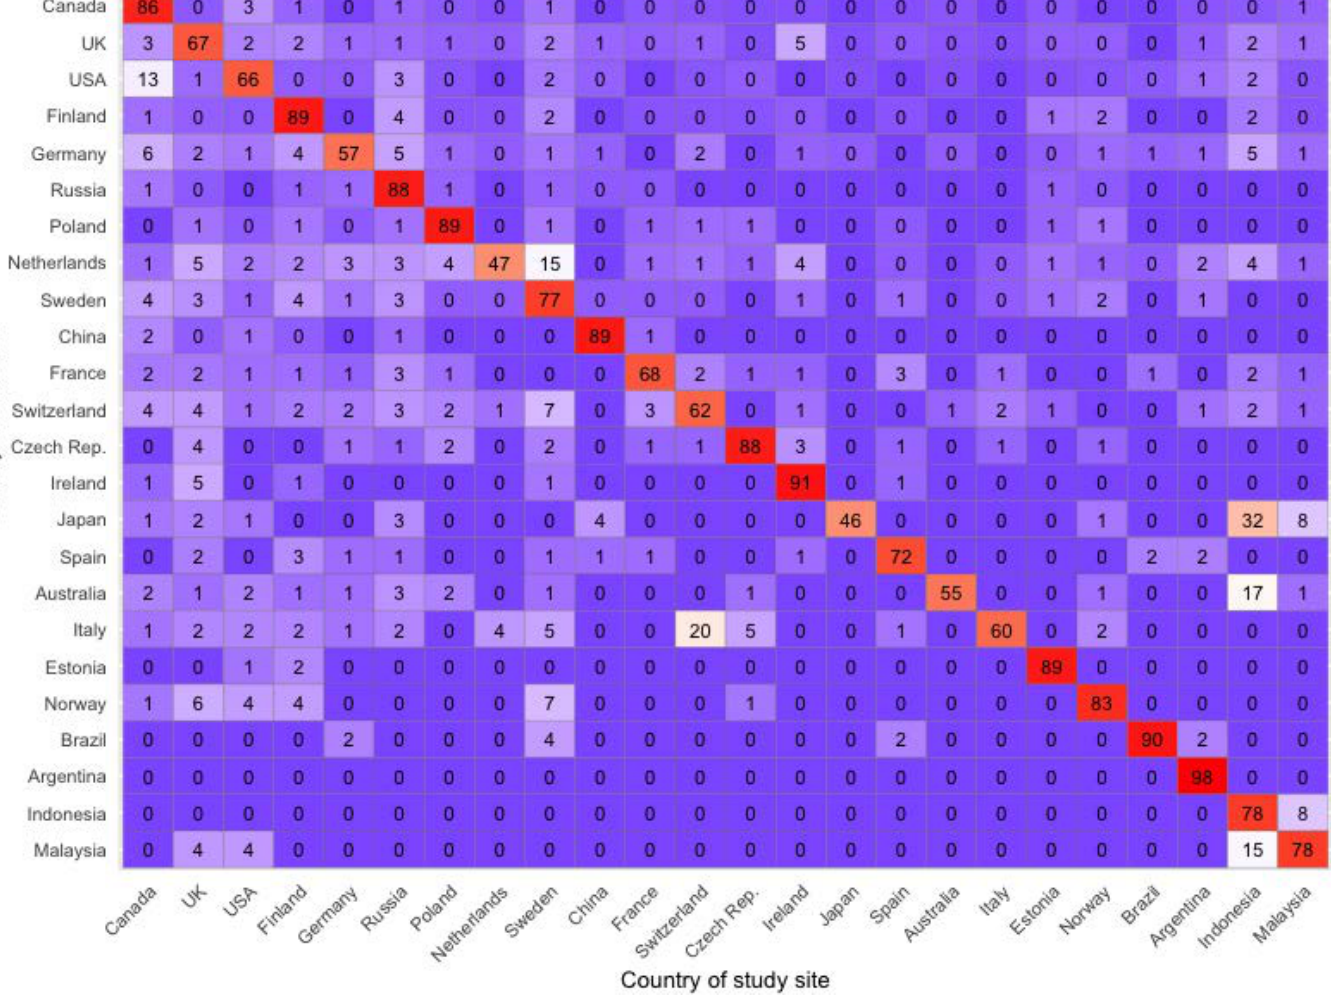
Figure 7. Proportion (%) of research performed according to the location of the study sites, relative to the total number of articles produced per country, with countries performing research listed vertically and study sites horizontally. Example of interpretation: 32 % of research performed by Japan was on study sites in